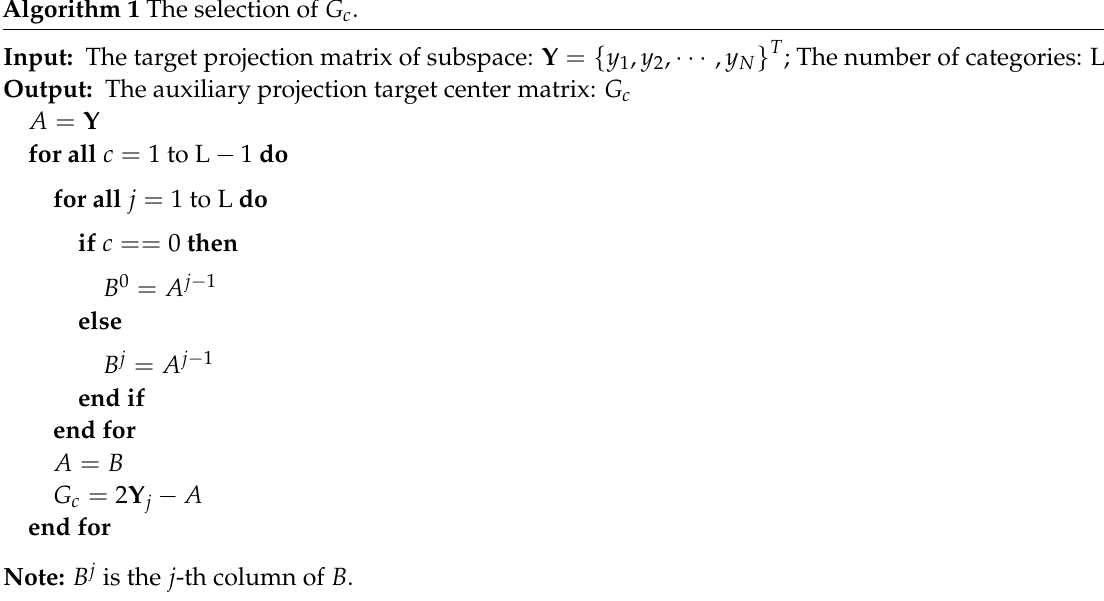
Algorithm 1 The selection of G c